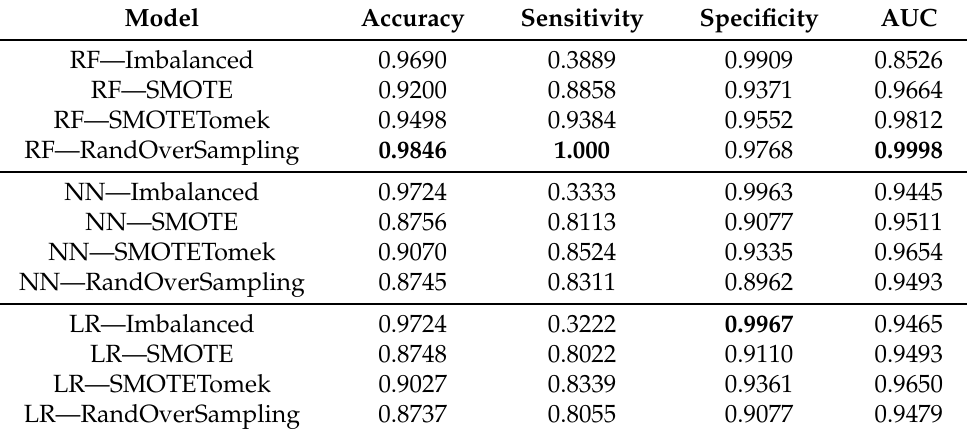
Table 10. Performance of RF, NN, and LR in the Default dataset. Values in bold are the maximum of each